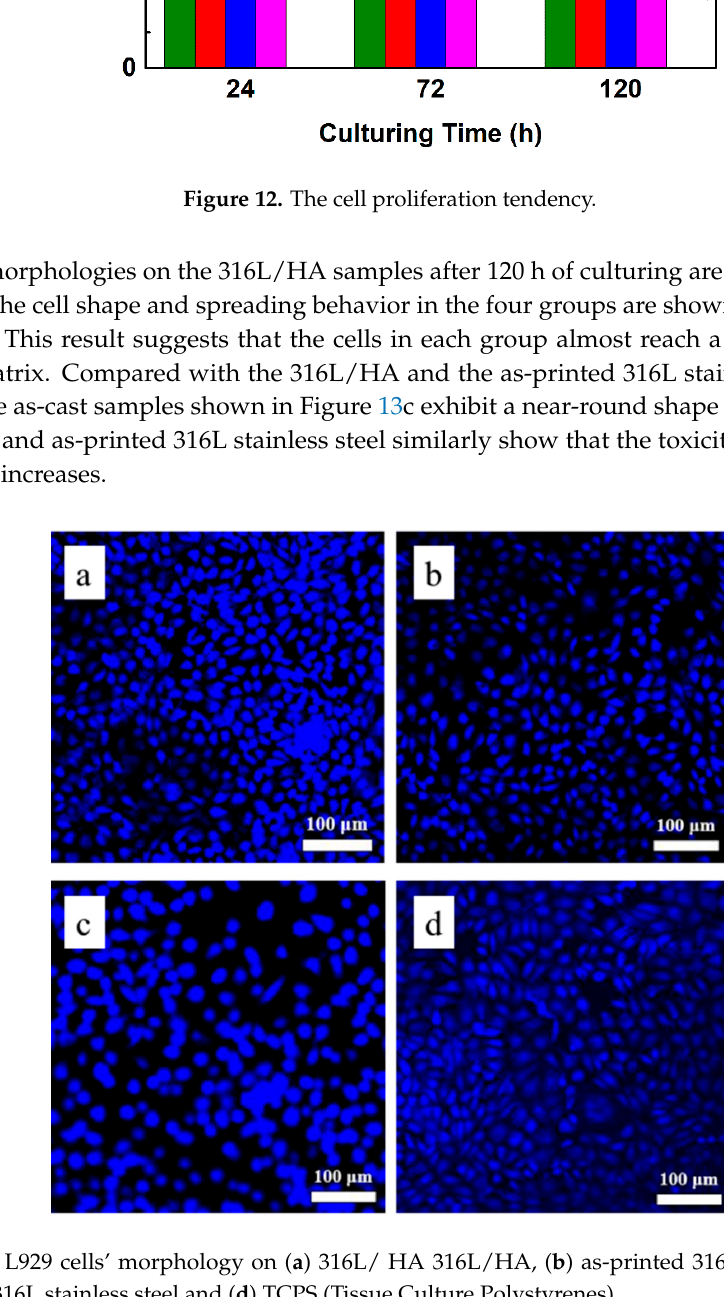
Figure 12. The cell proliferation tendency.